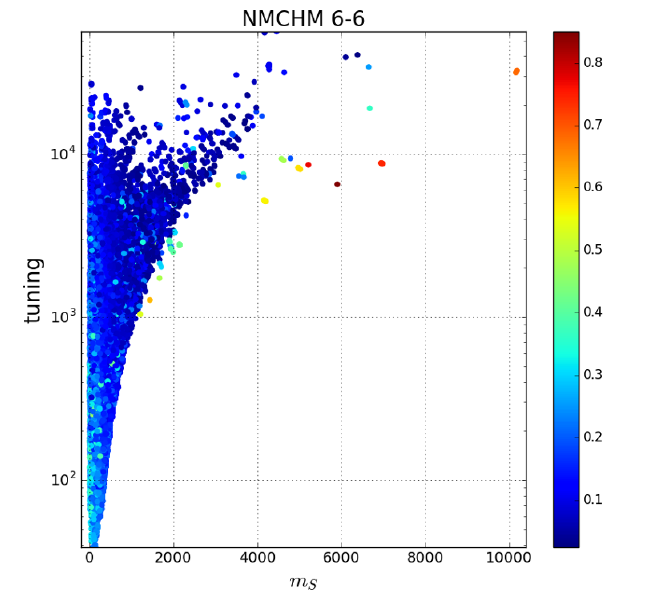
Figure 13. Mass of the singlet in GeV, with singlet-quark coupling deviation (as de(cid:12)ned in equation (A.14)) as the third